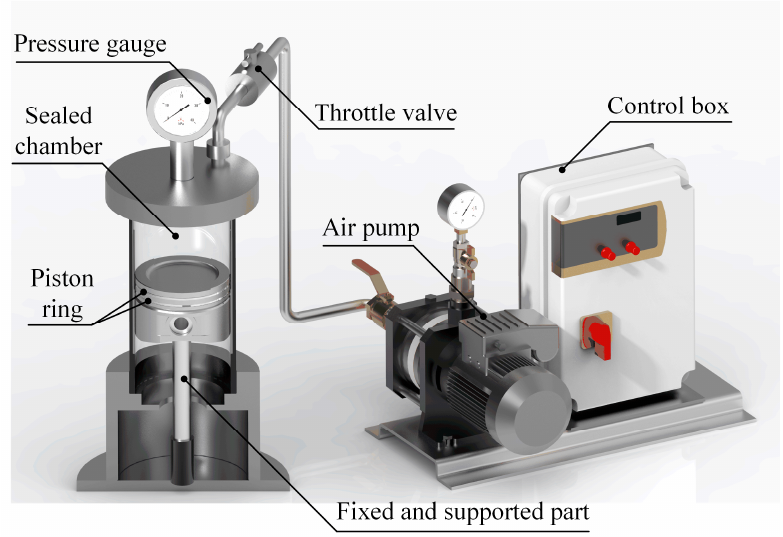
Figure 9. Static seal test bench for the piston ring.